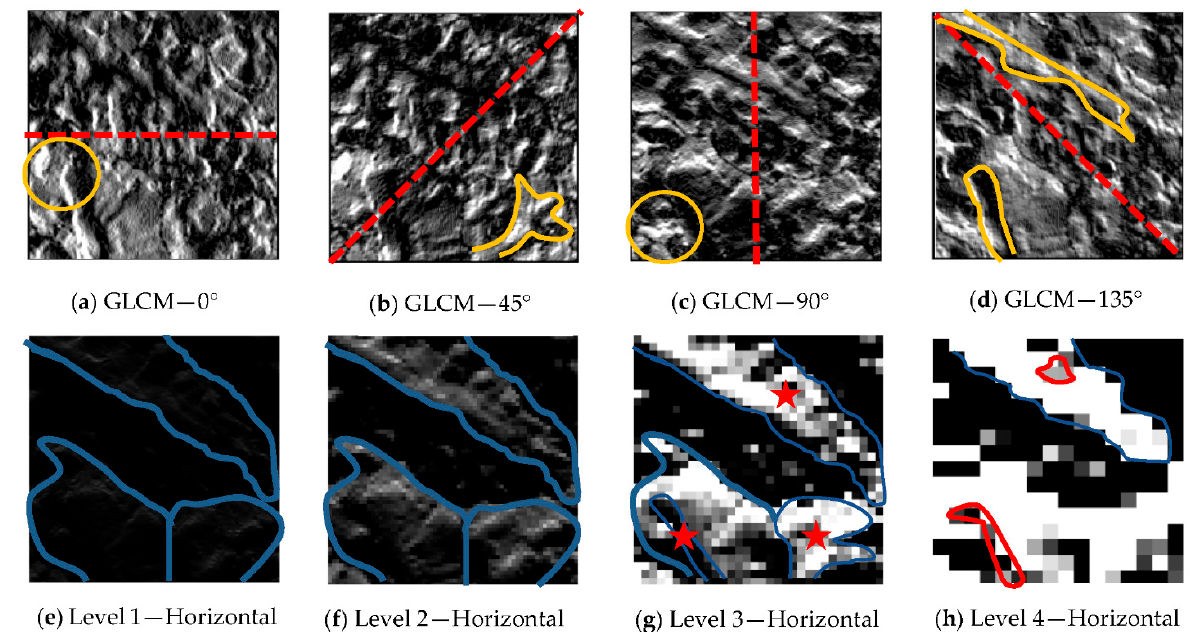
Figure 10. Landform spatial structure features of different texture analysis methods. ( a ) GLCM—0°; ( b ) GLCM—45°; ( c ) GLCM—90°; ( d ) GLCM—135°; ( e ) Level 1—Horizontal; ( f ) Level 2—Horizontal; ( g ) Level 3—Horizontal; ( h ) Level 4—Horizontal.